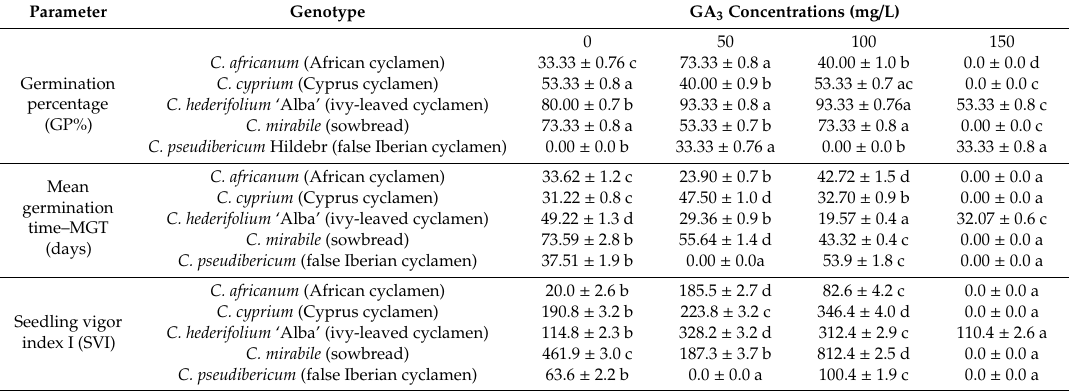
Table 1. E ff ects of increasing GA 3 concentrations (mg / L) on the indicated seed germination parameters of the five selected Cyclamen taxa.